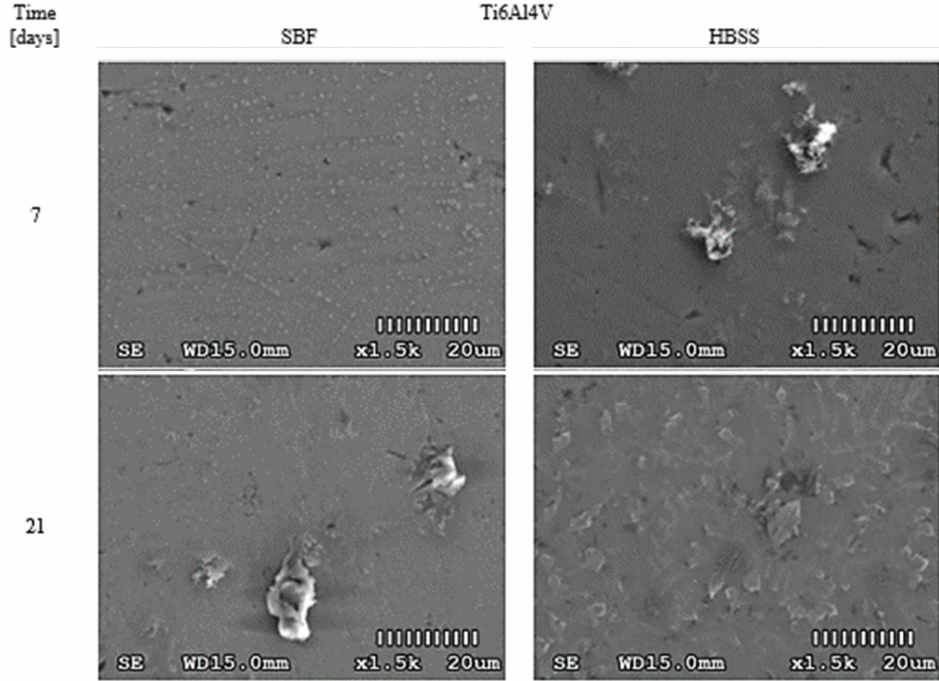
Figure A3. Morphological changes on the surface of Ti6Al4V immersed in SBF and HBSS after selected time